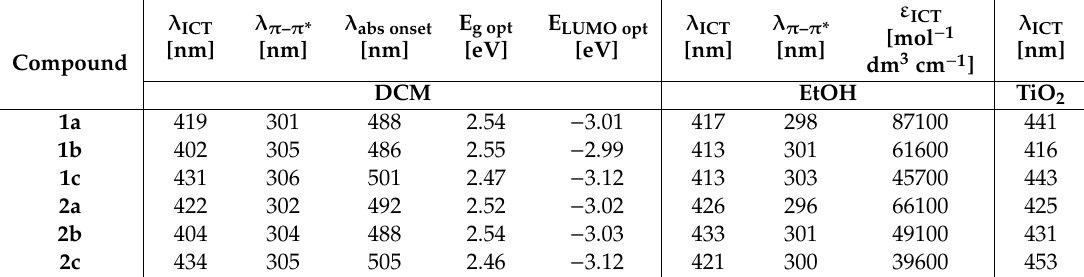
Table 3. Optical properties of the studied